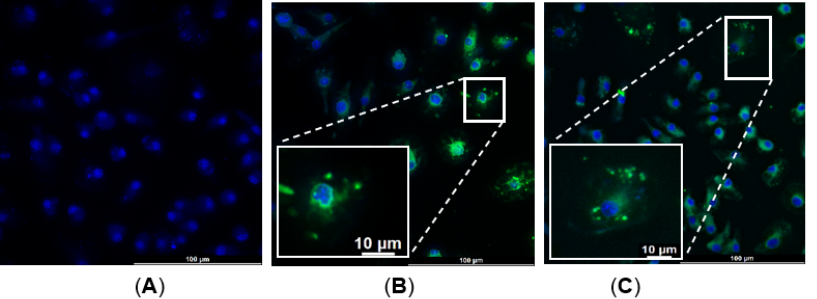
Figure 4. Isolated BMDMs were treated with α -MSH-SM-liposomes or plain SM-liposomes loaded with ICG (green) to study their cellular uptake. The cell nuclei were stained with DAPI (blue). Panel ( A ) represents isolated BMDM cells without liposomes used as a control. The BMDM cells were treated 30 min with SM-liposomes ( B ) or α -MSH-SM-liposomes ( C ); then, they were washed 3 times with PBS to get rid of the non-specific binding. (The images were taken at 63X magnification